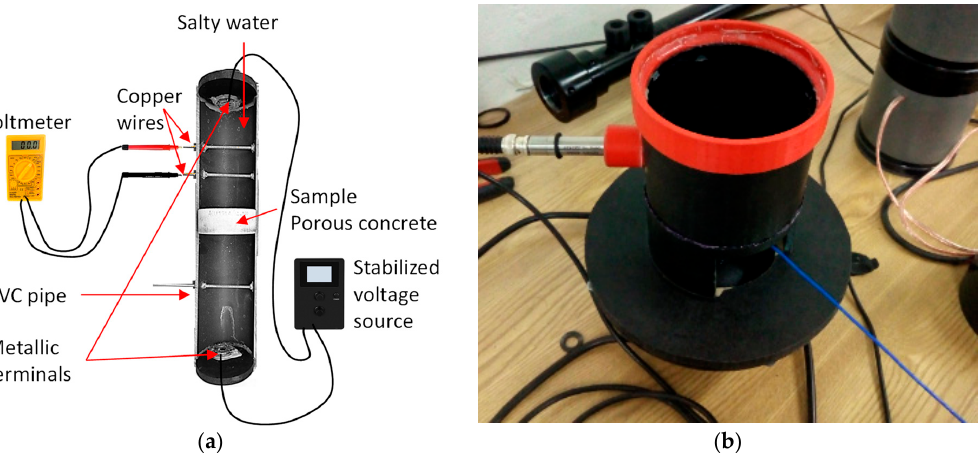
Figure 5. Experimental determination of macroscopic parameters of the porous concrete: ( a ) Sche-